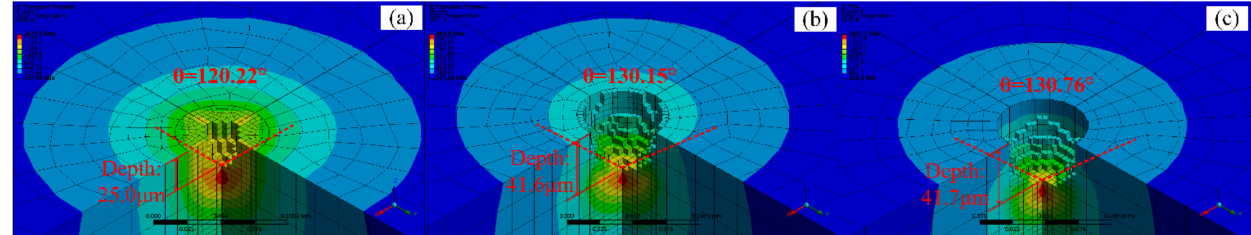
Figure 7. Simulation results of water jet-guided laser fixed-position drilling of titanium alloy: ( a ) the laser power is 5 W and the repetition frequency is 40 kHz, ( b ) the laser power is 9 W and the repetition frequency is 40 kHz, ( c ) the laser power is 9 W and the repetition frequency is 80